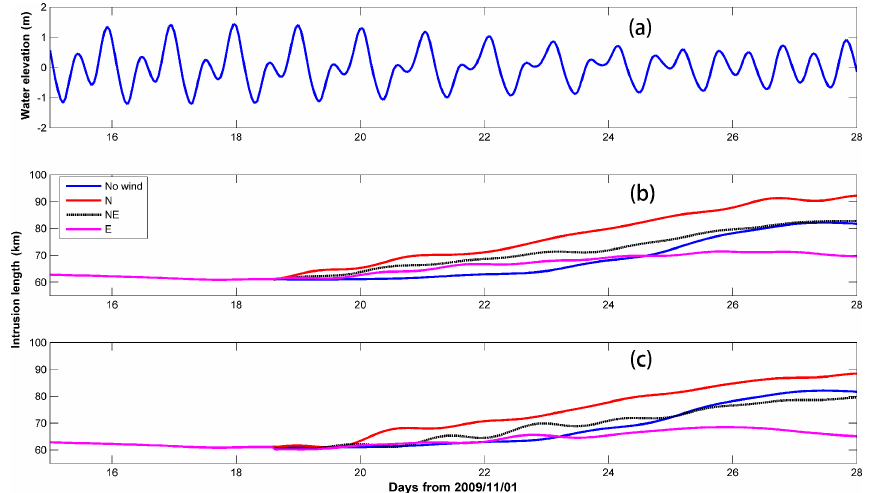
Figure 13. Comparison of lengths of the salt intrusion under different wind directions and the associated waves. Panel (a) time series of water level; panel (b) low-pass filtered lengths of the salt intrusion under different wind directions; panel c) low-pass filtered lengths of the salt intrusion under different wind directions and